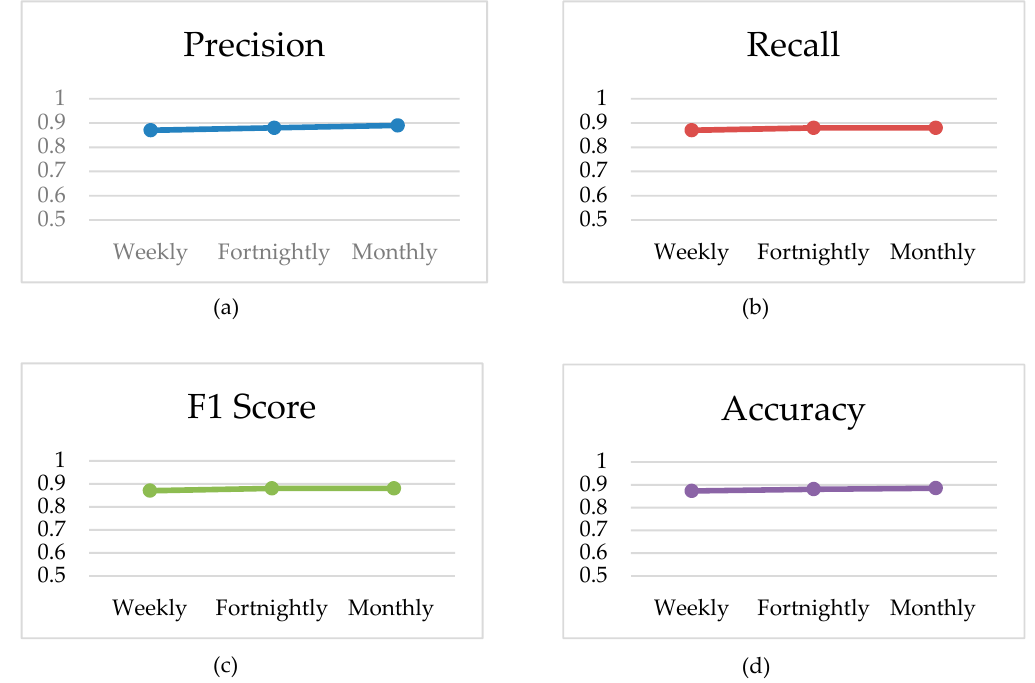
Figure 8. E ff ect of weekly, fortnightly, and monthly consumption patterns on the model. ( a ) Precision; ( b ) Recall; ( c ) F1 Score; ( d ) Accuracy.